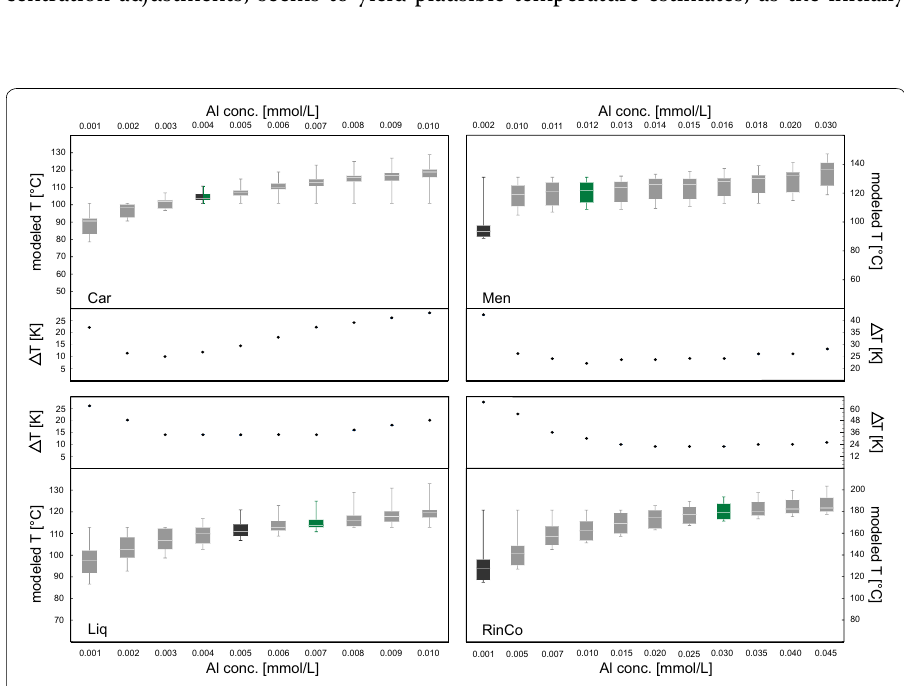
Fig. 8 Distribution of temperatures for selected Villarrica springs (Car, Men, Liq, RinCo) calculated by multi- component geothermometry together with the according temperature spreads ( ΔT ) are plotted versus alu- minum concentration. Measured aluminum concentrations are indicated in dark grey , most likely aluminum concentration in